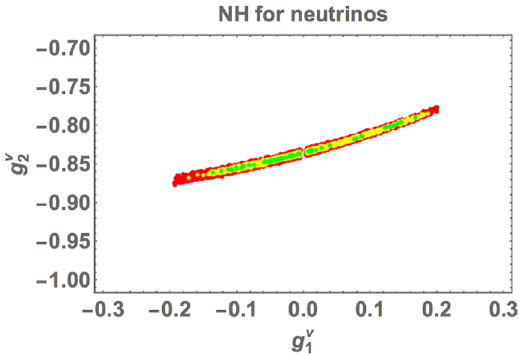
Figure 2 . The allowed region of g ν which are real parameters, for NH. Colors de- note same ones in figure 1.